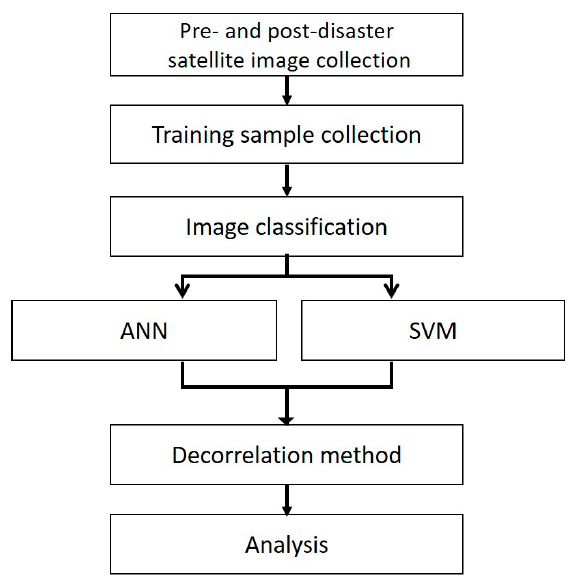
Figure 4. Flow chart of the method used to generate the damage maps for the Palu earthquake disaster.